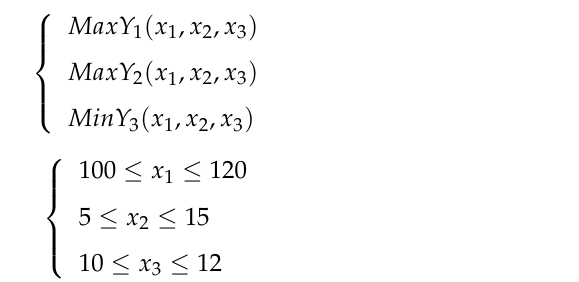
Figure 15. Influence of factor interaction on the variation coefficient of sandy soil removal velocity.